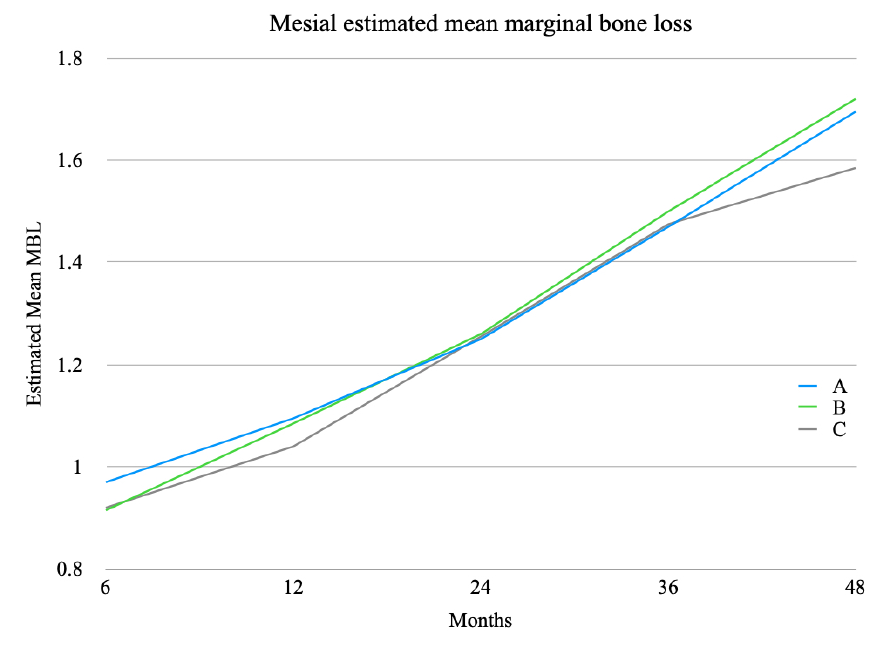
Figure 2. MBL for Implant 2, which tended to increase over the five time periods, irrespective of surgical